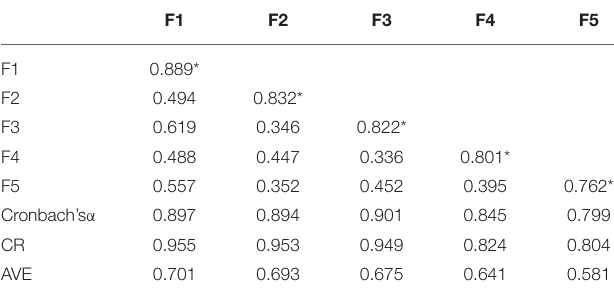
TABLE 9 | Reliability and validity test of each